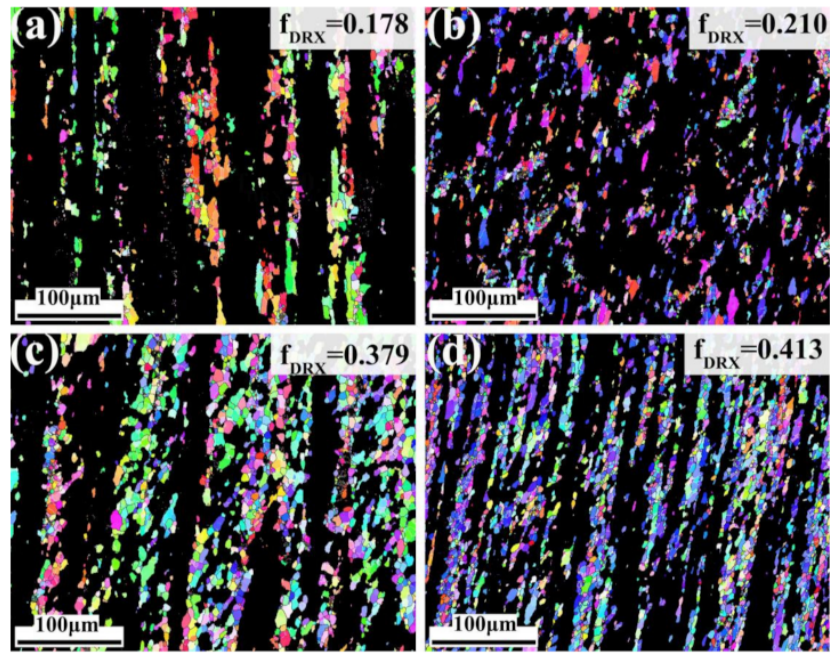
Figure 8. Dynamic recrystallization grain distribution of: ( a ) initial billet; ( b ) billet deformed by UE; ( c ) Zone V of direct ACAE-forming cabin; ( d ) Zone V of UE + ACAE-forming